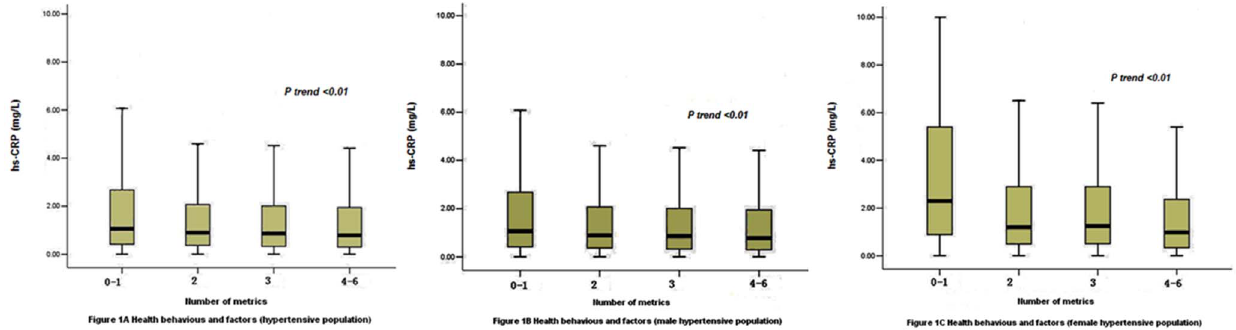
Figure 1. Serum hs-CRP indifferent groups of Ideal Cardiovascular Health Metrics in the hypertensive population, different genders hypertensive population. The hs-CRP levels are presented as box (median, 25th percentile, 75th percentile) and whisker (2.5th and 97.5th percentiles) plots.